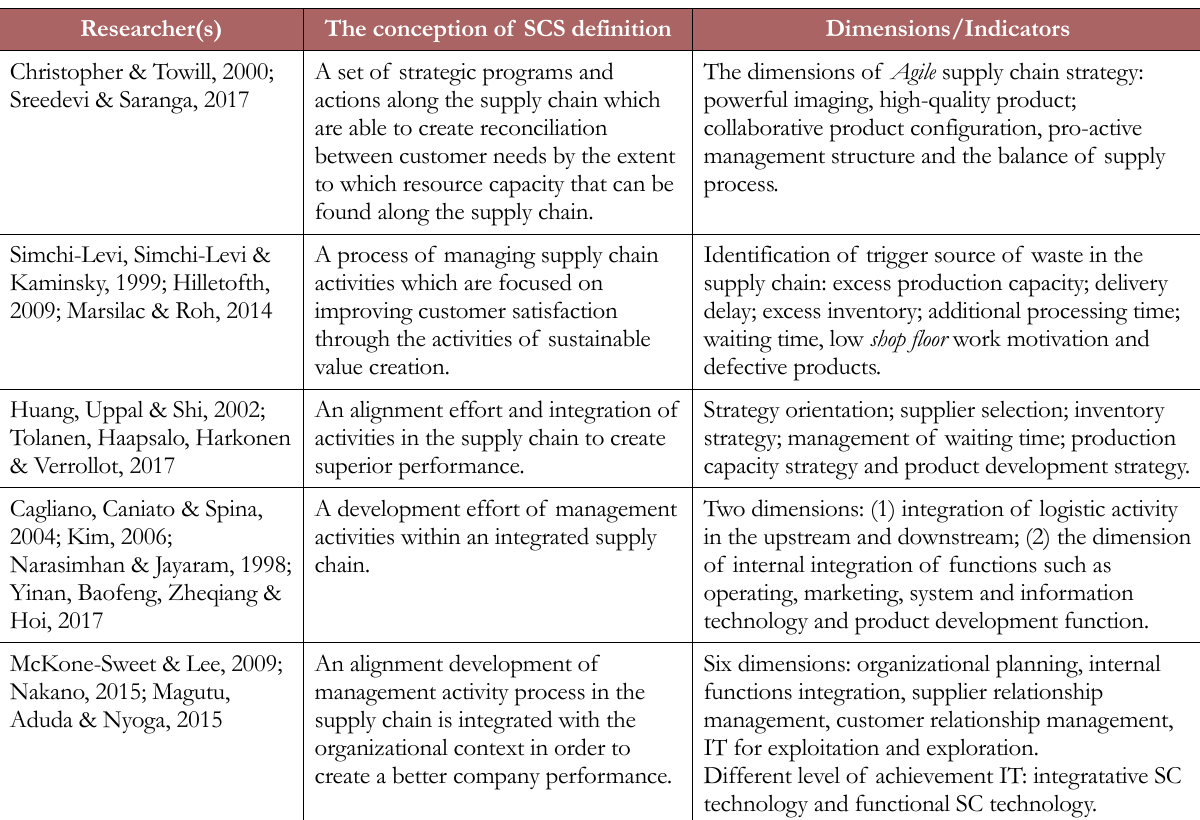
Table 1. Various opinions about the conception of